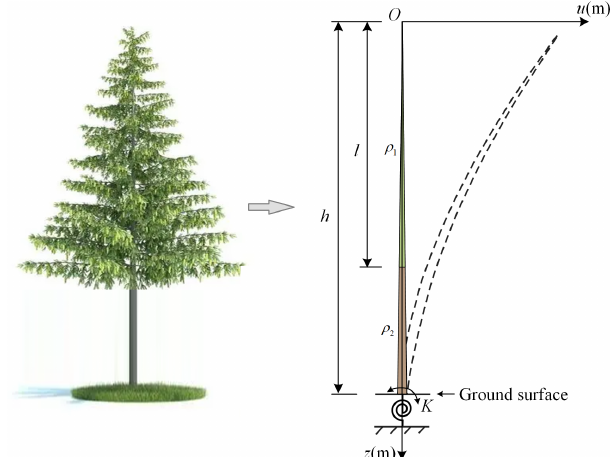
Figure 2. Schematic representation of the eigenfrequency predic- tion